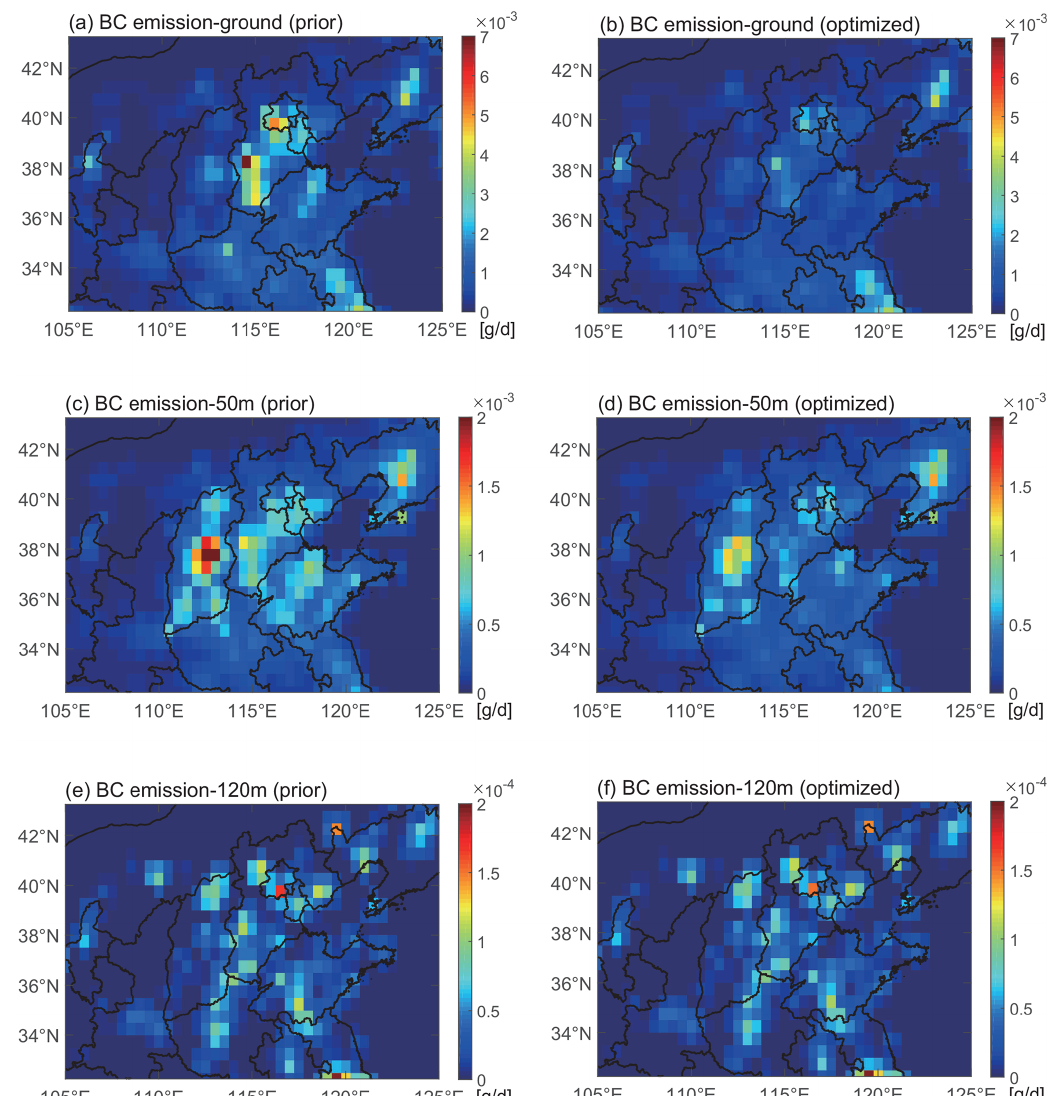
Figure 5. Spatial distributions of the (a, c, e) prior and (b, d, f) optimized daily BC emissions. The emissions are at three vertical levels: (a, b) non-point source on the ground, (c, d) middle-elevation point source at 50m and (e, f) high-elevation point source at 120m, as required by the GRAPES–CUACE model.